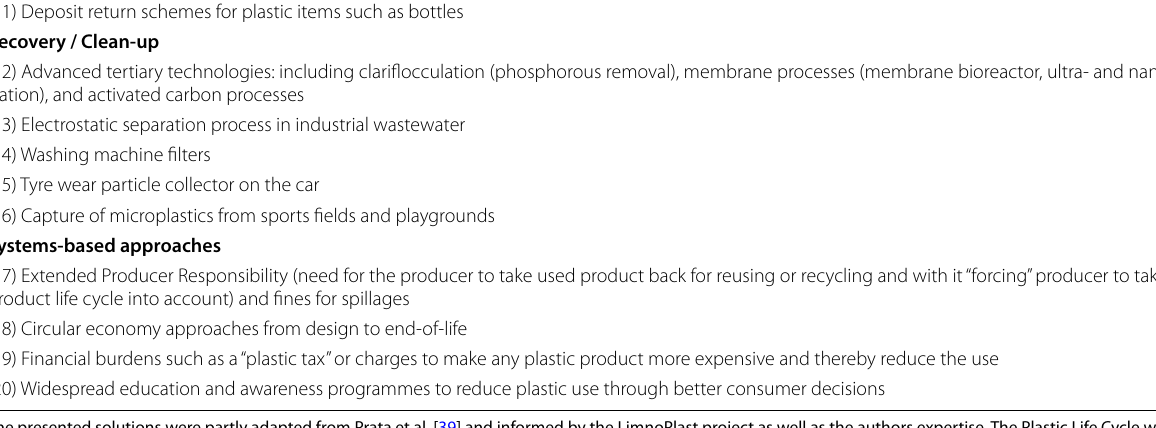
The presented solutions were partly adapted from Prata et al. [39] and informed by the LimnoPlast project as well as the authors expertise. The Plastic Life Cycle was adapted from UNEP’s Life Cycle Initiative (https:// www. lifec yclei nitia tive. org/ life- cycle- appro ach- to- plast ic- pollu tion/) [40]